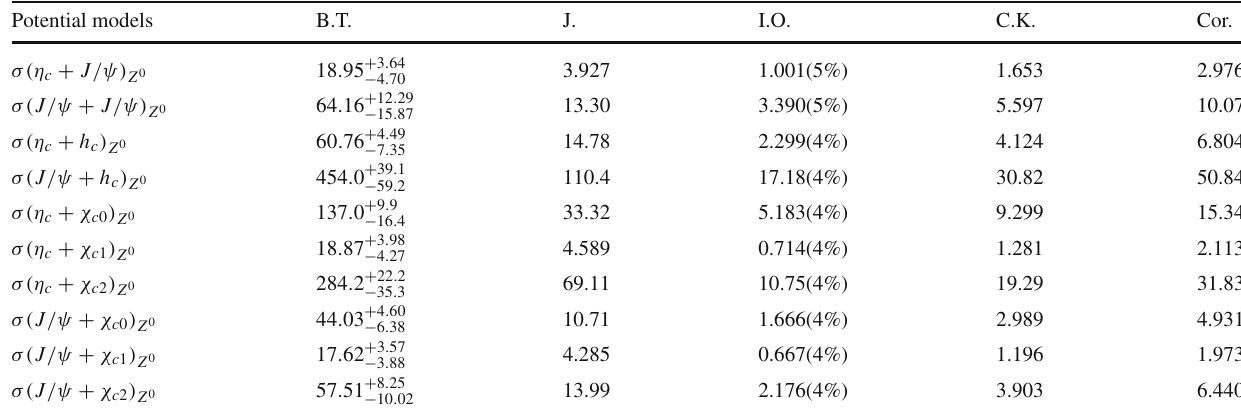
Table 4 Uncertainties of the total cross sections (units: × 10 − 5 f b ) caused by constituent quark masses under B.T. model, and by four other potential models for Z 0 propagated channels of double charmonia at